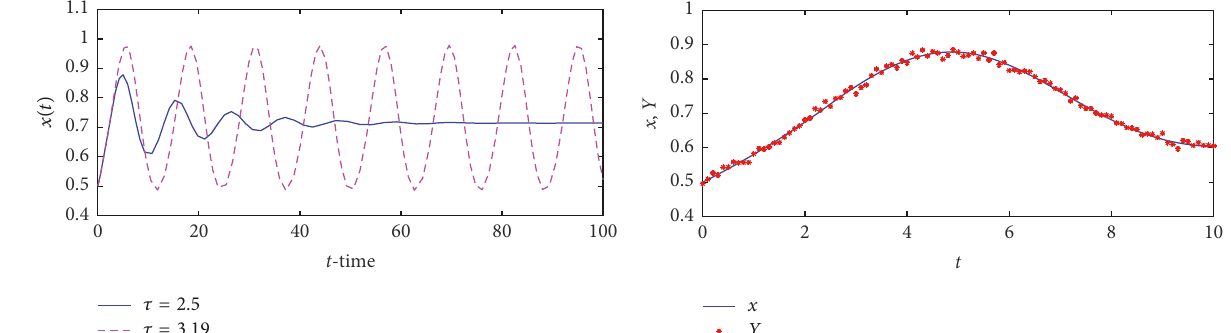
(b) Numerical solution of the DLDEM with two delays (41) using the estimated parameter values. The stars are the simulated noisy data by adding noises to the DLDE solutions at 𝑛 + 1 = 101 equally spaced time